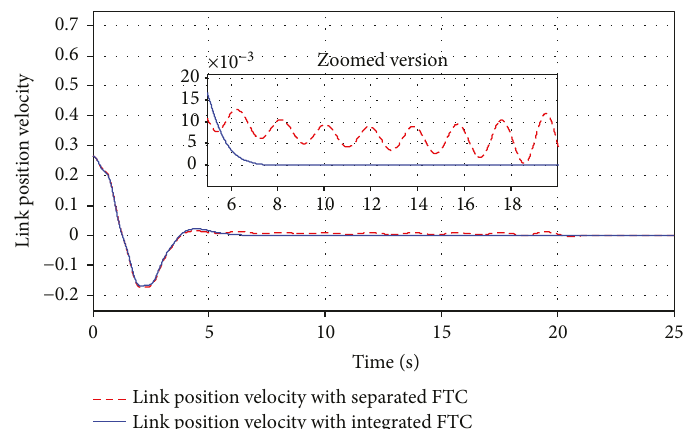
Figure 9: Third closed-loop system output response: output response with the separated FE-based FTC (red line) and output response with the integrated FE-based FTC (blue